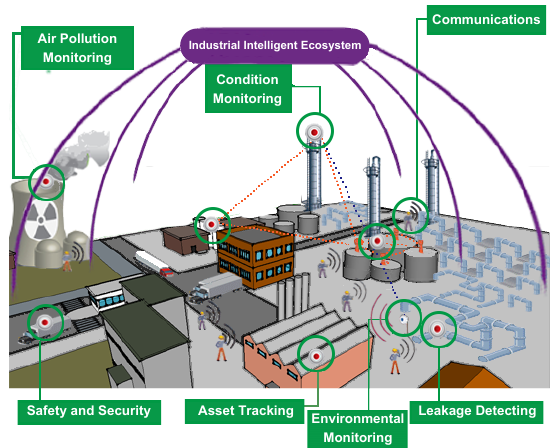
Figure 1. An industrial intelligence ecosystem. In this ecosystem, different objects (e.g., humans and machines) are working as an efficient whole with effective dynamic collaboration. The ecosystem consists of two parts: (i) sensing of humans with smart devices; humans (workers) share information with each other and with various sensors; and (ii) sensing of sensors embedded in machines. Through the sensors that are embedded in different industrial equipment, a variety of status information (even weather information) can be obtained and shared with other information